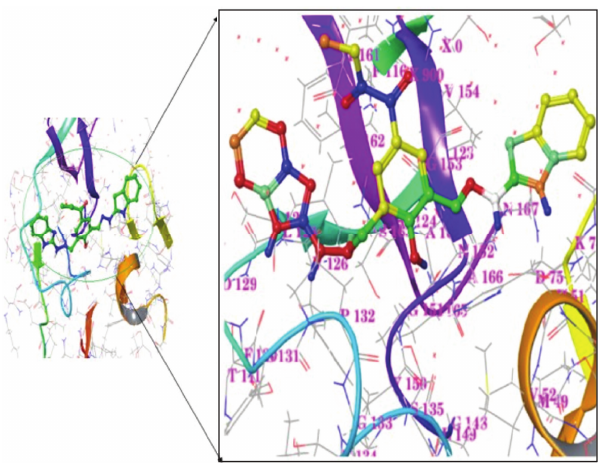
Figure 4: A close-up view representation of docked complexes from MM-GBSA analysis. The ligand maintains the direct contact with Phe130, Gly153, Gly151, and Asp75 indicated in the circled regions and zoomed on with their nearest residues indicated.